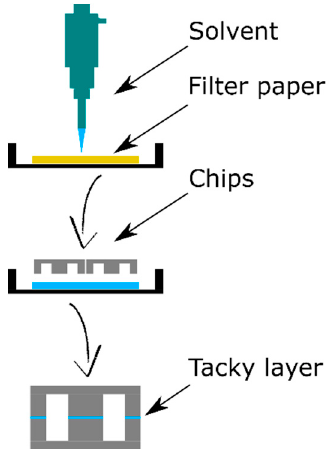
Figure 2. Schematic side-view of the COC bonding process using the tacky layer method. It starts by adding a piece of filter paper to a Petri dish and soaking it with a mixture of acetone and cyclohexane. The chip parts were placed on top of the filter paper for 2 min, subsequently aligned, and a 2 kg weight was placed on top for 5 min.